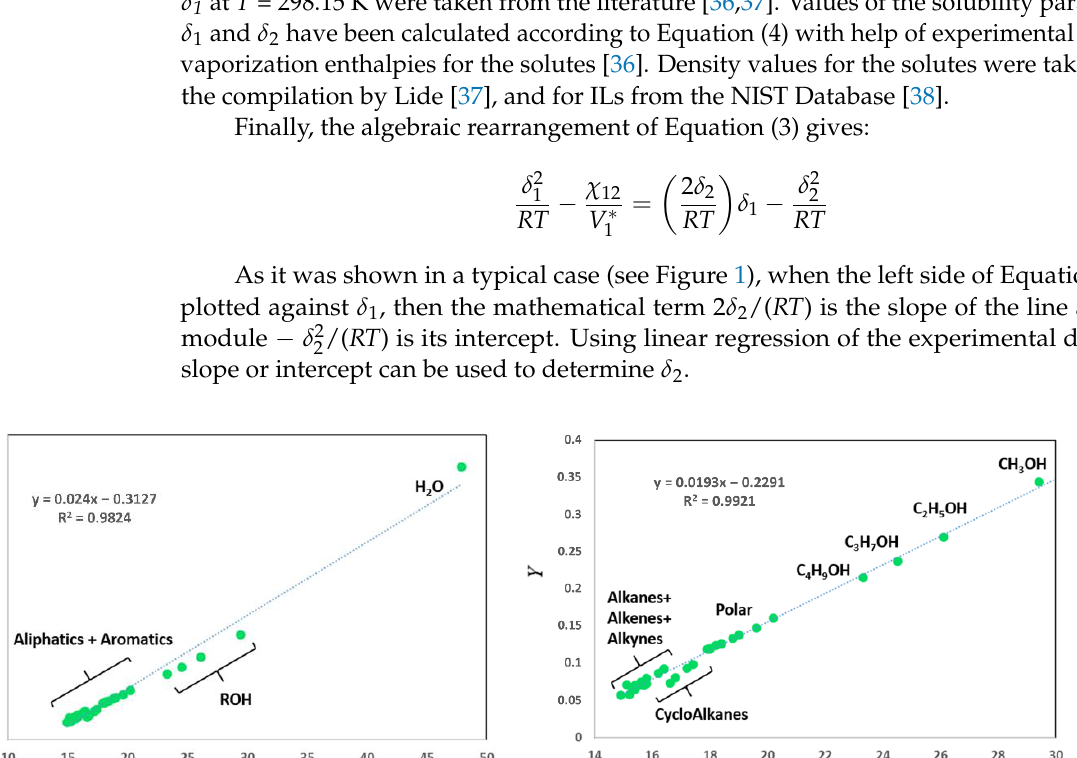
is the left 1 values [39]. ( Left ): the whole data. ( Right ): the same 1